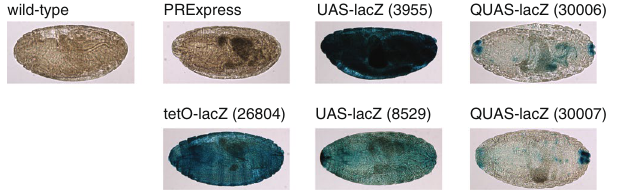
Figure 4. Leakiness of lacZ transgenes under UAS , QUAS , and tetO promoters. X-gal staining of embryos collected overnight (0–16 hours). Wild-type and PRExpress embryos showed no blue staining, whereas UAS, QUAS, and tetO lines showed blue staining indicating leakiness of their